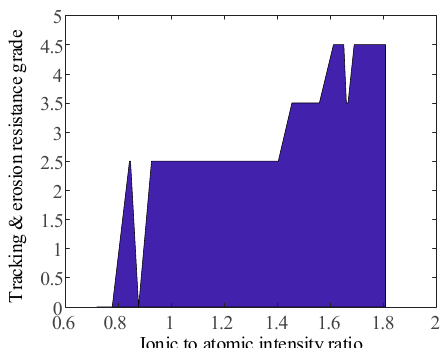
Figure 14. Relationship between the intensity ratio of Mg II 309.7 nm to Mg I 316.8 nm and the tracking and erosion resistance grade.